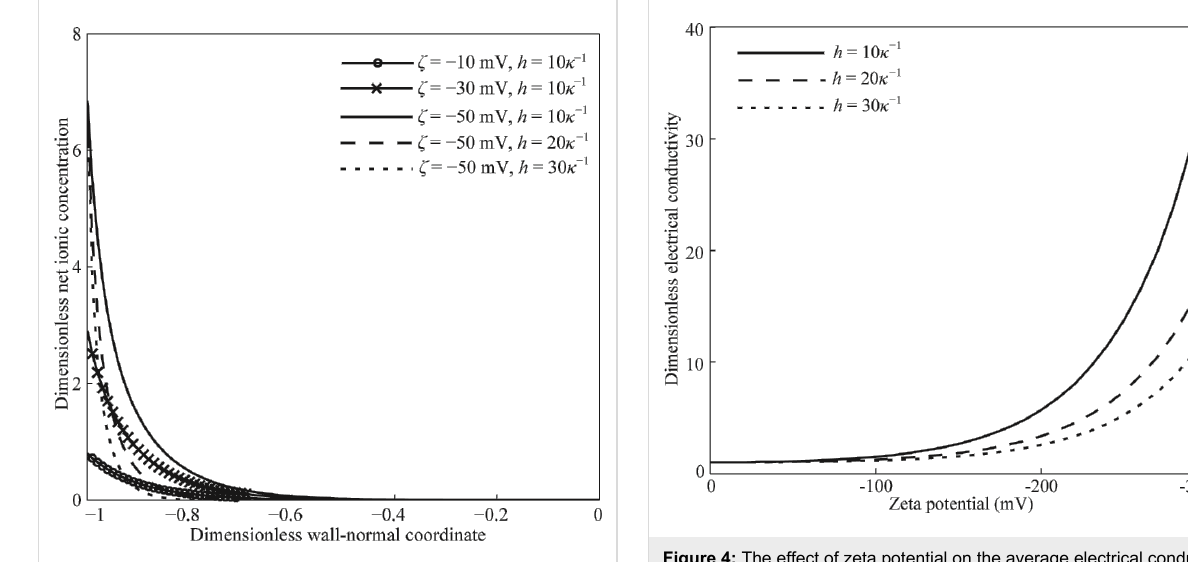
Figure 3: The dimensionless net ionic concentration as a function of dimensionless wall-normal coordinate in the non-overlapping EDL.